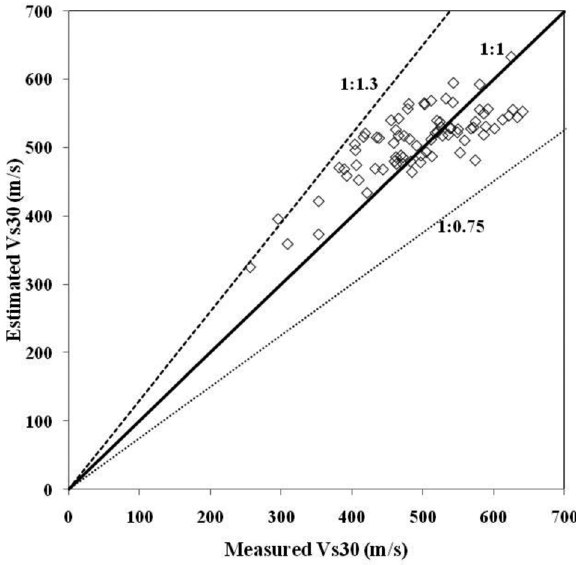
30 versus measured V Figure 12. Estimated V s 1:1 and 1:0.75 that shows good correlation between estimated and 30 measured V s